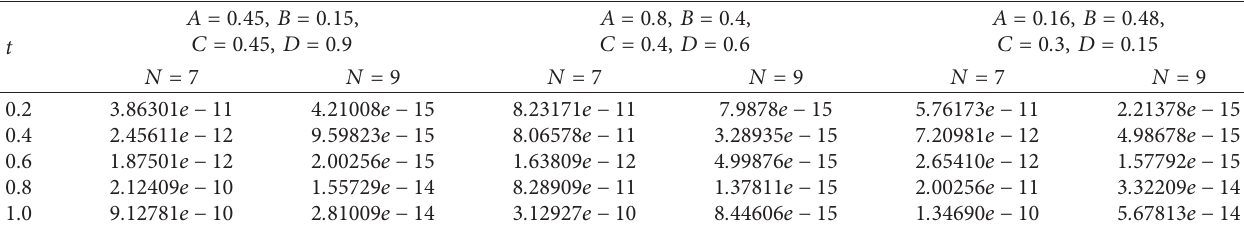
Table 3: Comparison of the absolute errors obtained by different rates for R